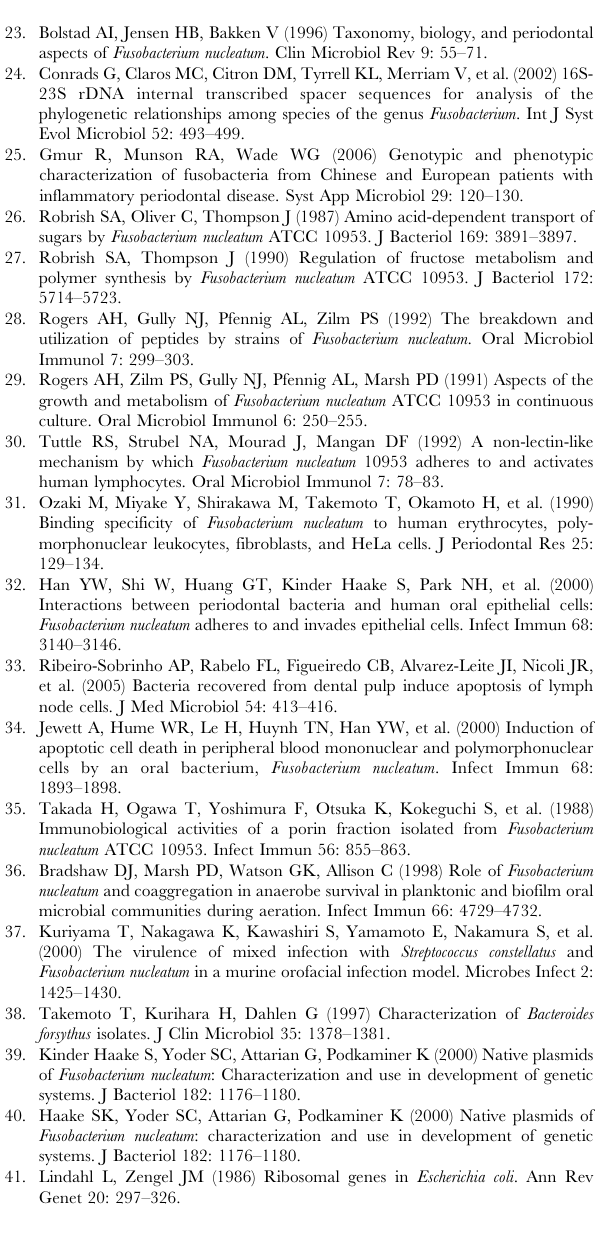
Table S1 FNP ORFS not in FNN or FNV; FNP ORFS not in FNN; and FNP ORFS not found in FNV.